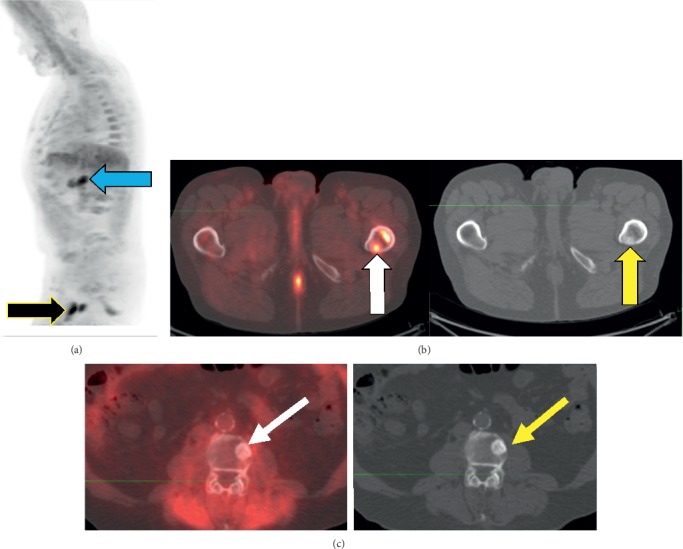
Images of a 79-year-old male who had undergone radical prostatectomy, salvage radiation, and proton beam therapy for oligometastases to L3 and multiple lymph nodes. He was referred for 18F-fluciclovine imaging with PSA rising to 2.03 ng/mL. (a) MIP view, sagittal plane. The black arrow points to enhanced uptake, consistent with metastasis in the proximal left femur. The blue arrow points to the pancreas (normal physiologic uptake). (b) Axial, fused PET/CT image (white arrow) and corresponding CT view (yellow arrow) show a metastasis in the proximal left femur. (c) Of interest, this PET/CT view and the corresponding CT view show a previously-irradiated metastasis in L3; note the absence of 18F-fluciclovine uptake (white arrow) on PET and presence of sclerosis on CT (yellow arrow).